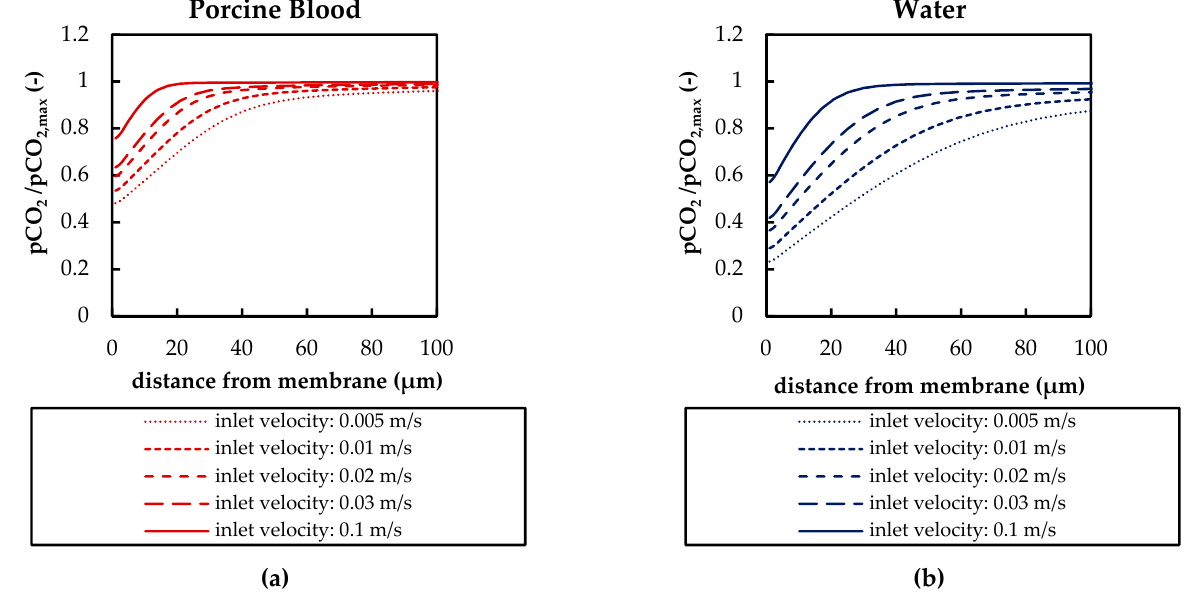
Figure 16. Boundary profiles (sampling line illustrated in Figure 7a) of normalized CO 2 partial pressure (pCO 2 /pCO 2,max ) for different inlet CO 2 partial pressures: ( a ) porcine blood, ( b ) water.